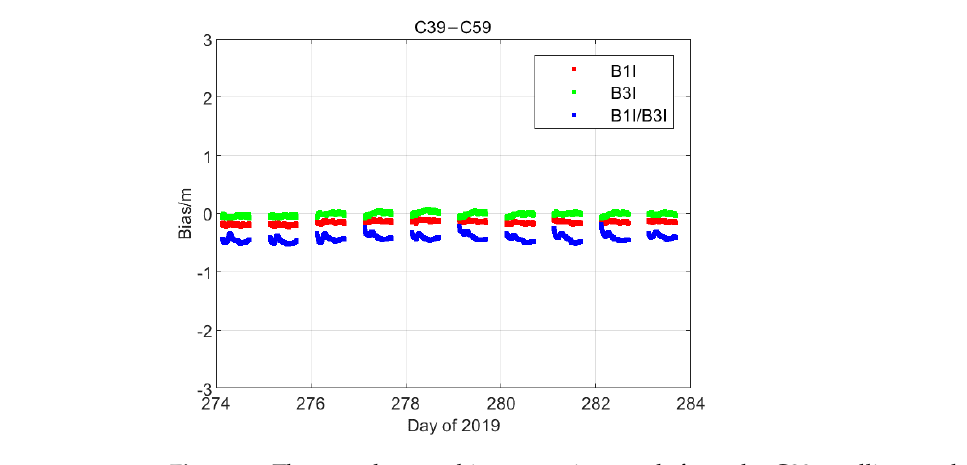
Figure 1. The pseudorange bias extraction result from the C01 satellite, as obtained by the type B receiver.